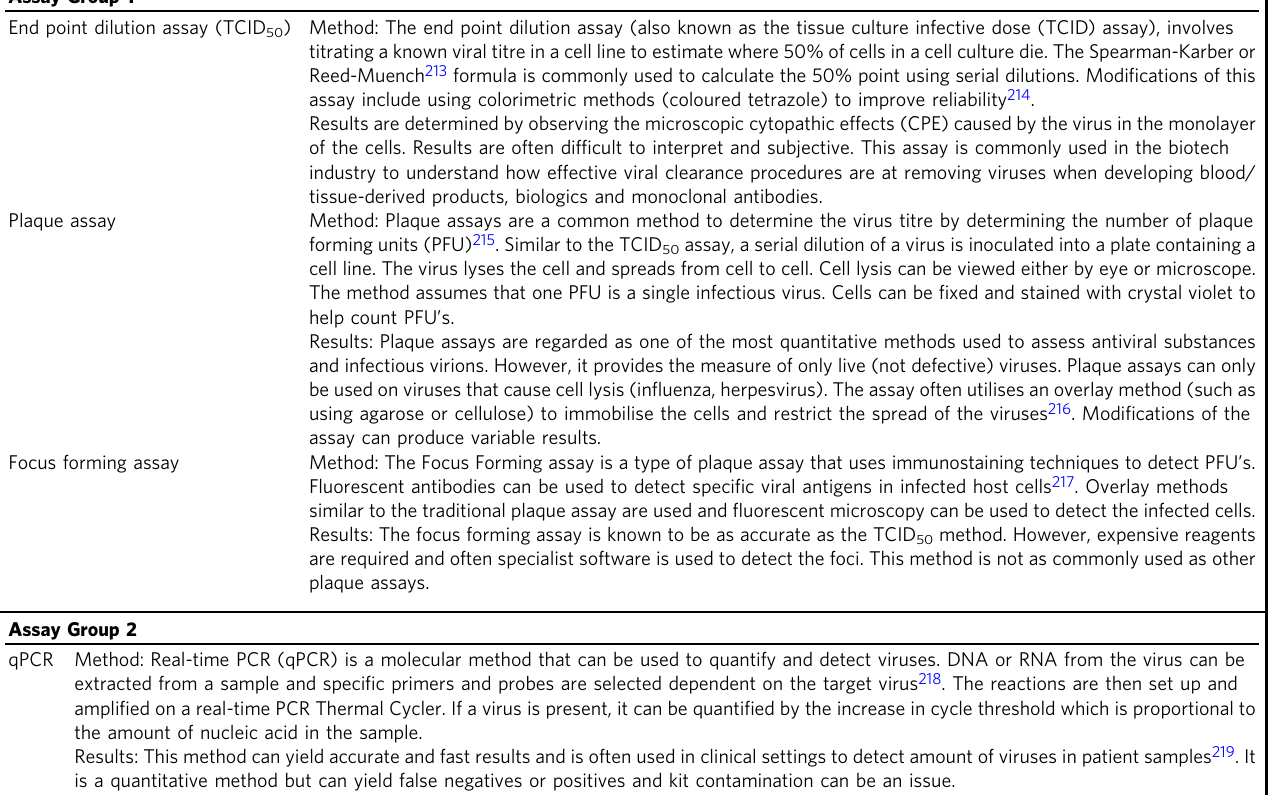
Table 2 Overview of methods to detect viruses and measure their activity used in virology. Assay Group